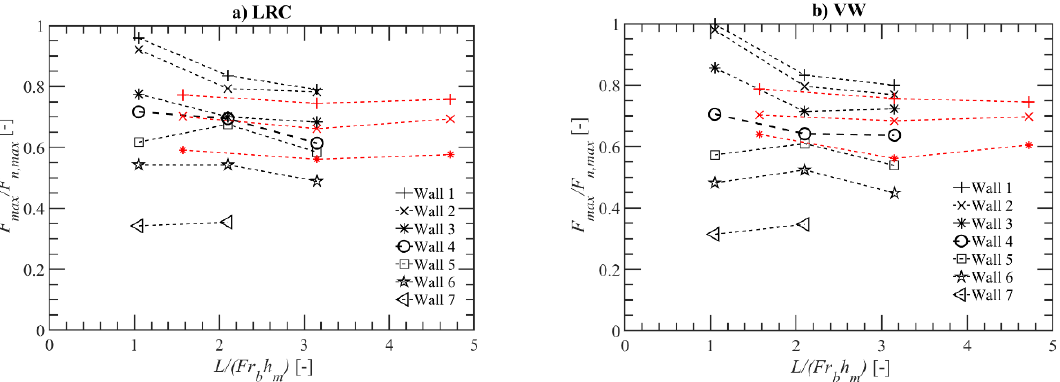
Figure 15. Effect of L in the horizontal force variation (black— d o = 0.9 m and red— d o = 0.6 m).